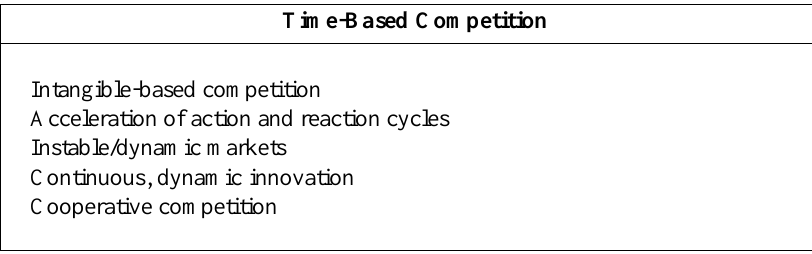
Table 1 : Time-Based Competition in Conditions of